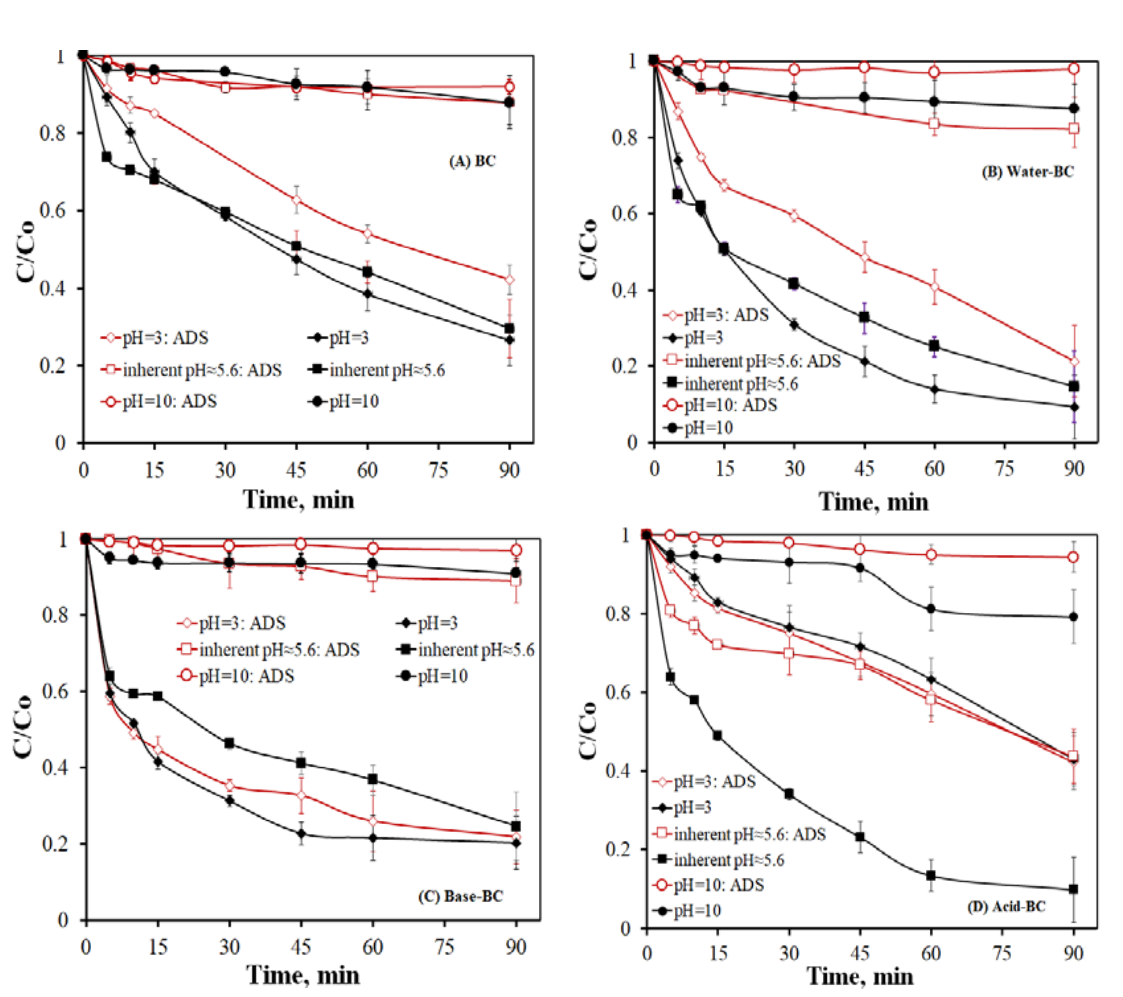
Figure 4. Effect of initial pH on 250 μ g/L LOS degradation using 250 mg/L SPS and 90 mg/L of ( A ) BC, ( B ) water–BC, ( C ) base-BC, and ( D ) acid–BC in UPW. The corresponding adsorption experiments (without SPS) are also shown.